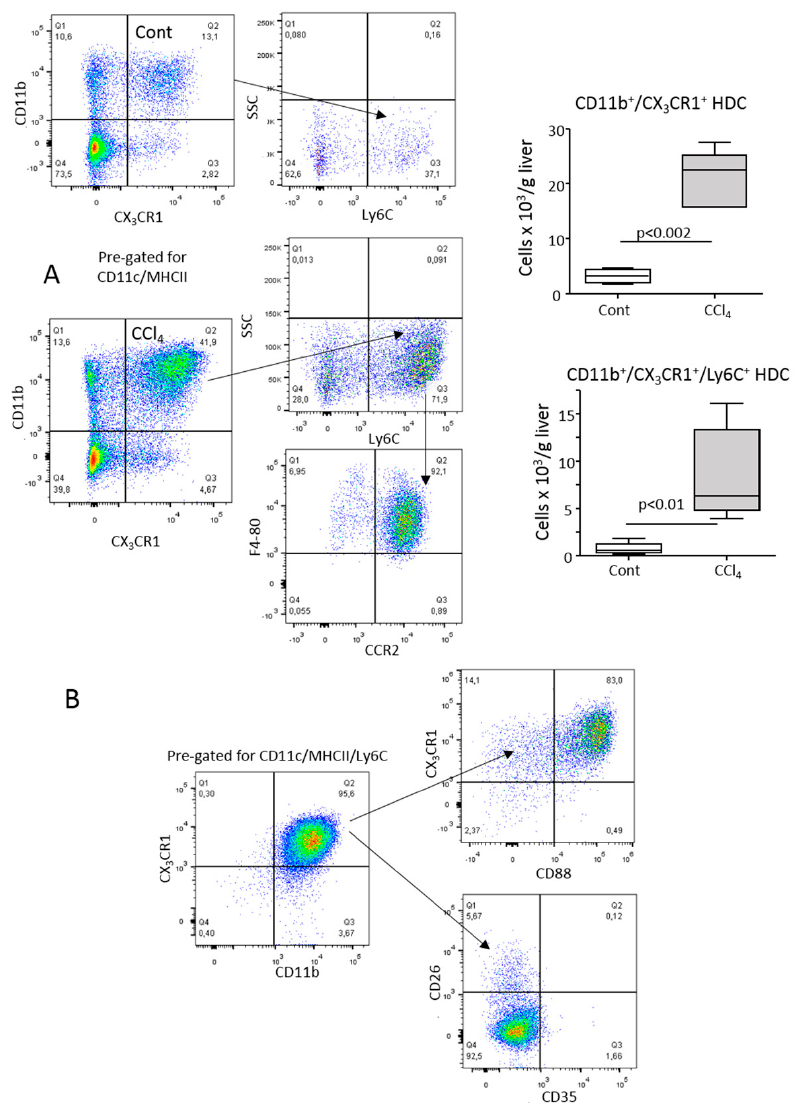
Figure 2. Characterization of hepatic dendritic cells (HDCs) expanding in response to acute liver injury. ( A ) CD11c + / MHCII high / CD11b + HDCs from either naïve (Cont) or CCl 4 -treated mice (CCl 4 ) were analyzed by flow cytometry for the expression of CX 3 CR1 and the monocyte markers Ly6C, F4-80 and CCR2. The values are expressed as means ± SD of three di ff erent cell preparations. ( B ) Relative distribution of the dendritic cell and macrophage markers CD26, CD35 and CD88 among CD11c + / MHCII high / CD11b + / Ly6C + / CX 3 CR1 + HDCs.